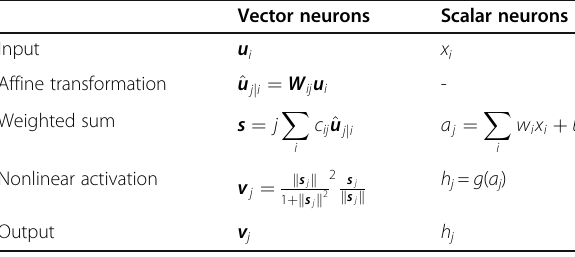
Table 1 Differences between vector neurons and scalar neurons Vector neurons Scalar